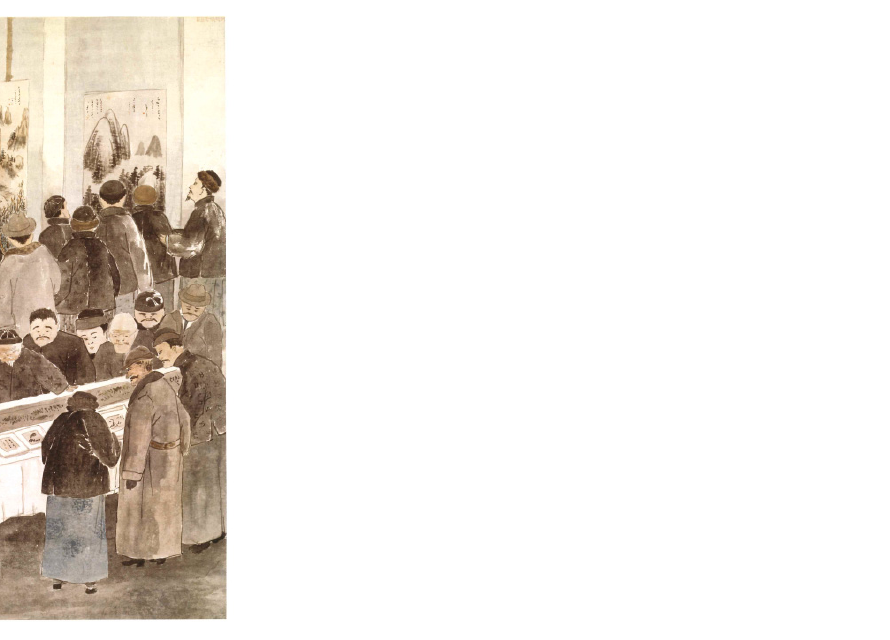
Figure 2. Chen Shizeng (1876–1923), Viewing Paintings ( Du hua tu ), 1918. Ink and color on paper, 87.6 × 46.6. The Palace Museum.